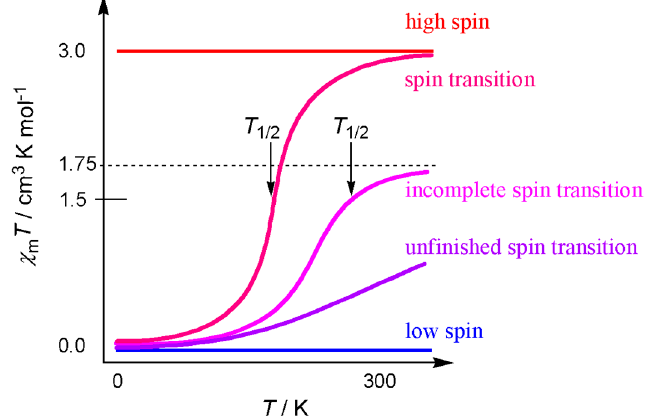
Figure 7. The spin-only values of the high-spin, low-spin, and paramagnetic limits for a symmet- rical linear S rad – S Ni2+ – S rad system. Classification of spin-transition behavior will be referred from Sections 2.4 and 2.5.